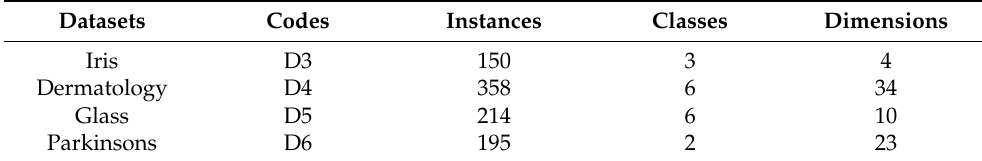
Table 1. UCI real datasets.